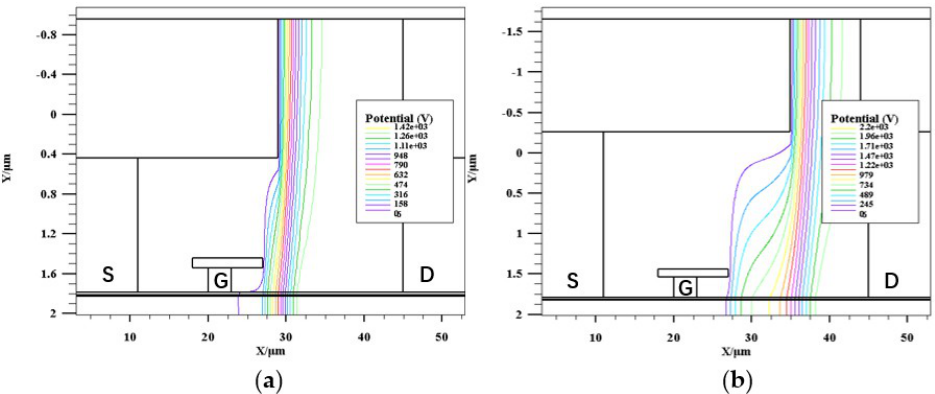
Figure 11. The Potential distributions in HEMT. ( a ) L FP-S = 18 µ m with t 2 = 1250 nm at V BD = 1420 V; ( b ) L FP-S = 24 µ m with t 2 = 1950 nm at V BD = 2200